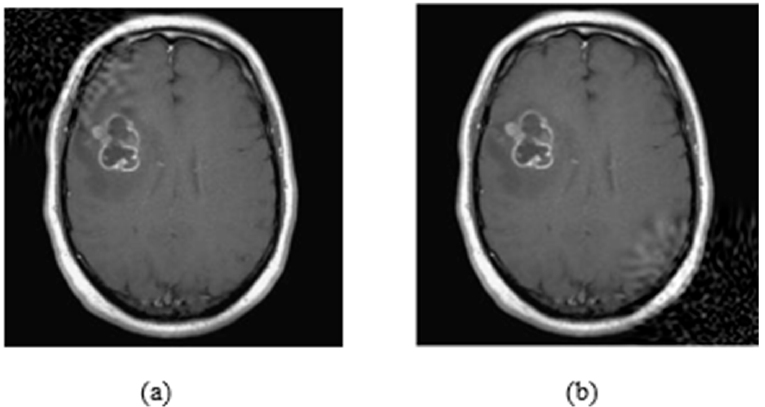
Figure 3. ( a ) Watermark embedding with p 1 = 0.1 and p 2 = 0.1, ( b ) Watermark embedding with p 1 = 0.9 and p 2 = 0.9.